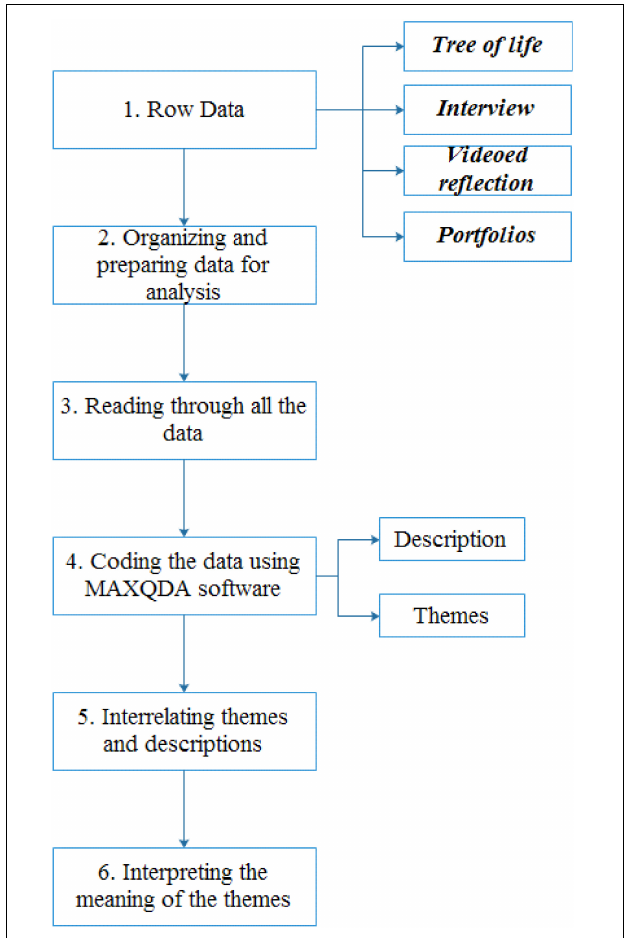
FIGURE 2 | The stepwise data analysis